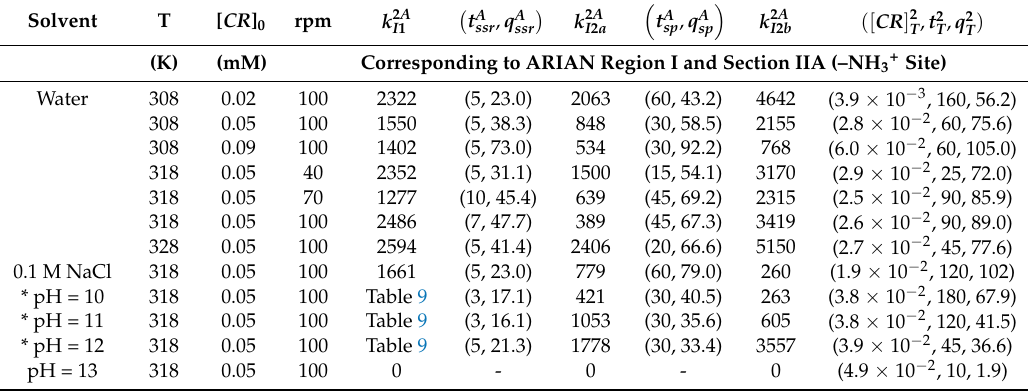
, k 2 A I 2 a , and k 2 A are 1 I 2 b